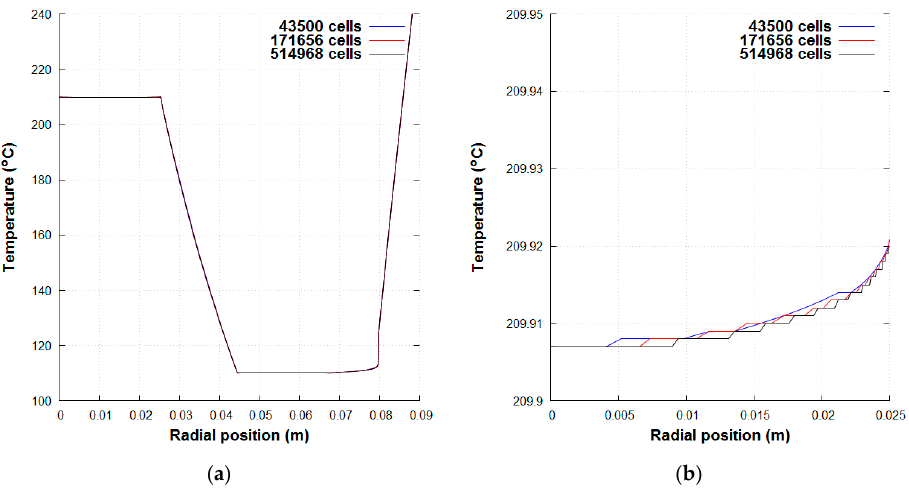
Figure 3. Mesh-independence study for the CFD model—( a ) Radial Temperature taken in the middle of the model (at 5 m); ( b ) Focus on the radial temperature in the internal tubing.